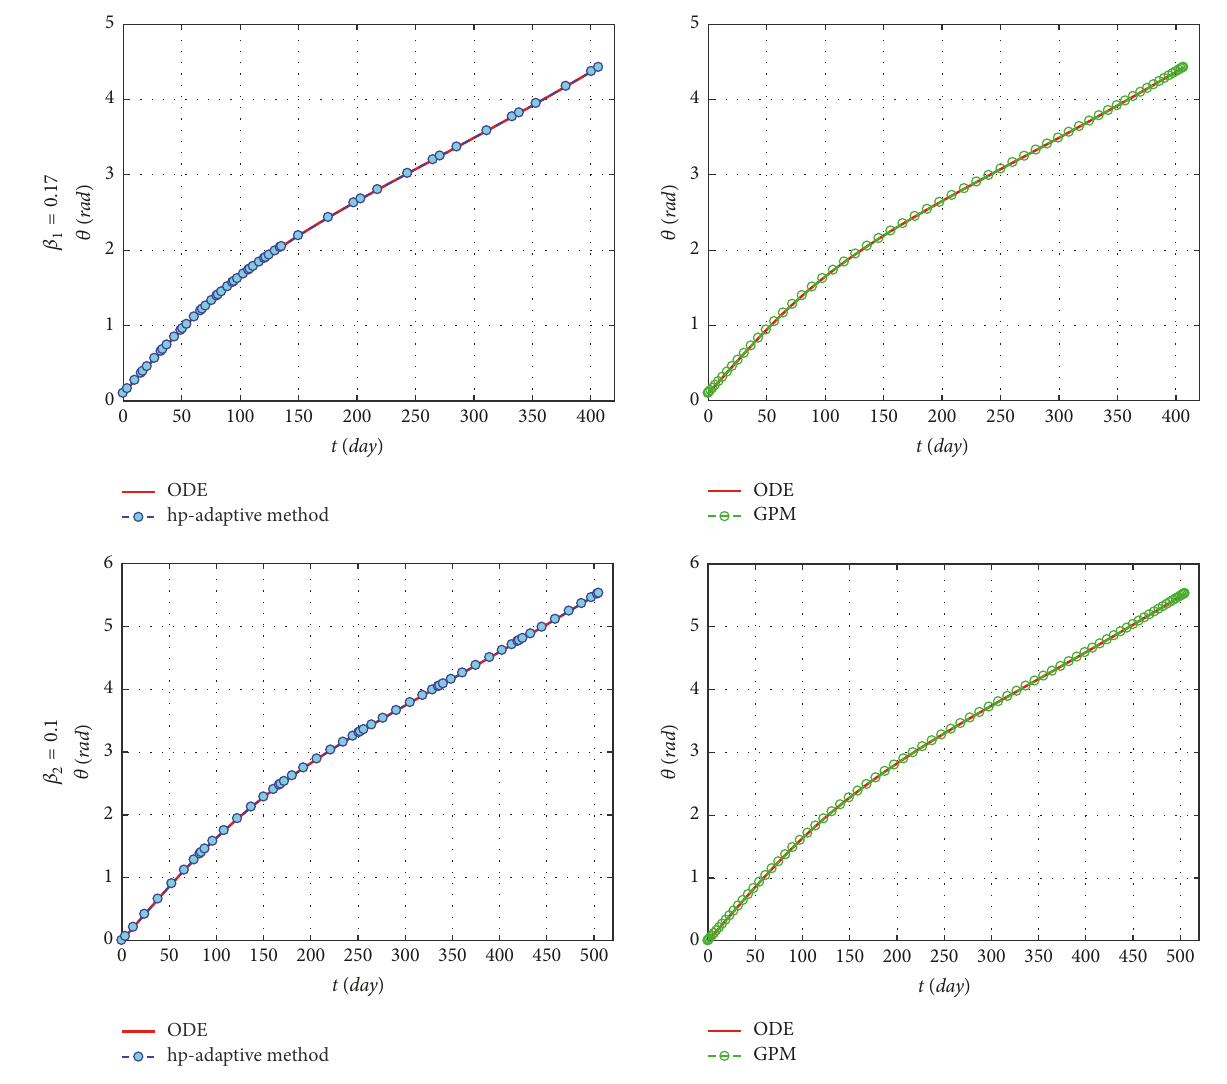
Figure 7: The angular position of transfer orbit. Table 3: Performance comparison between hp -adaptive method and